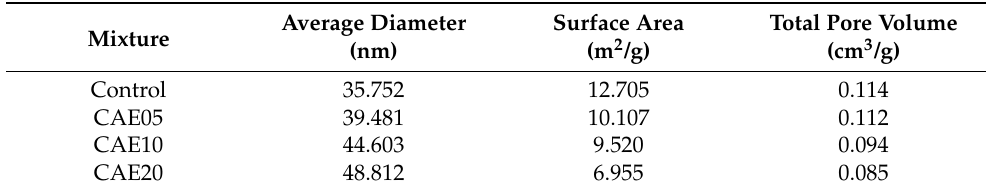
Table 4. BET surface and total pore volume results.